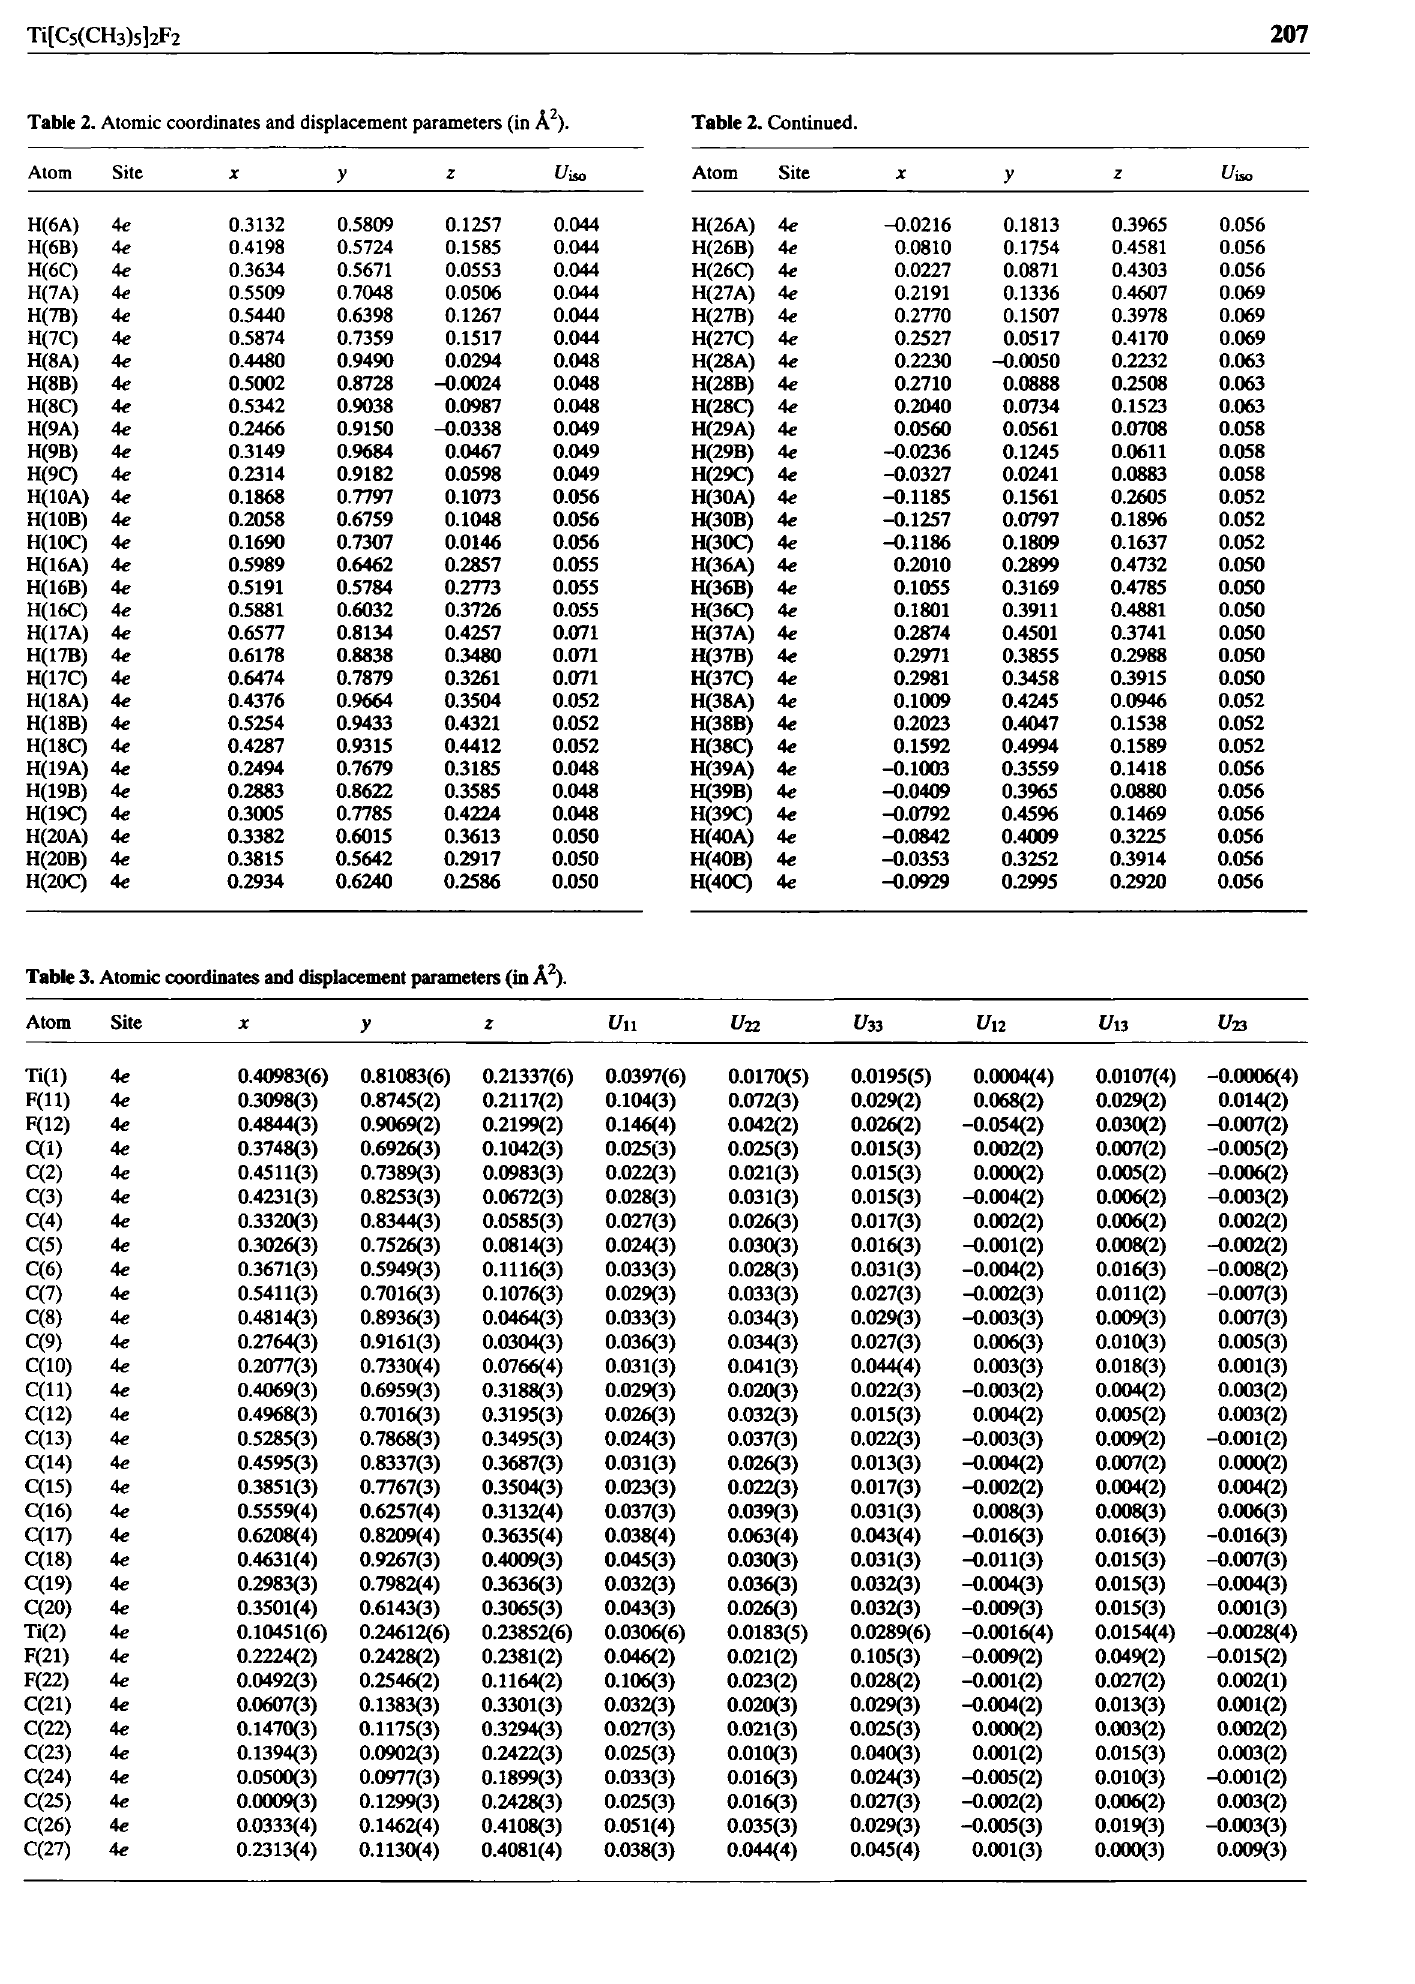
Table 2. Atomic coordinates and displacement parameters (in A 2 ).